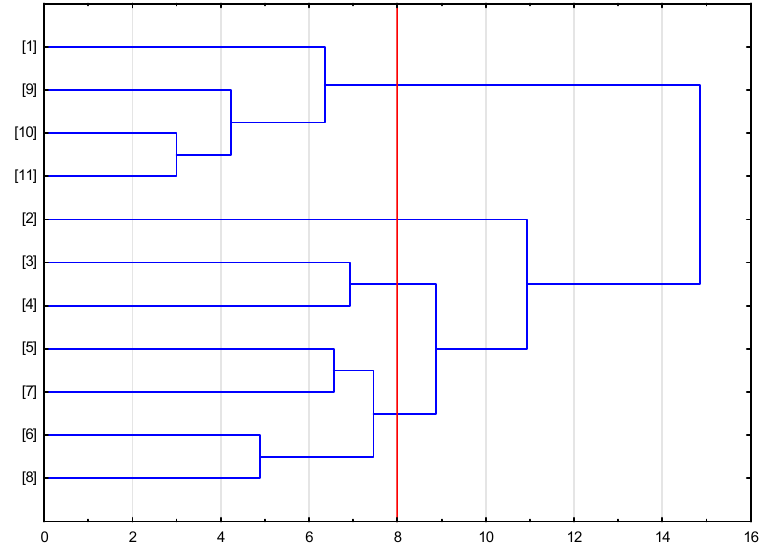
Figure 6. Results of cluster analysis for threats of LGUs using the Ward method.